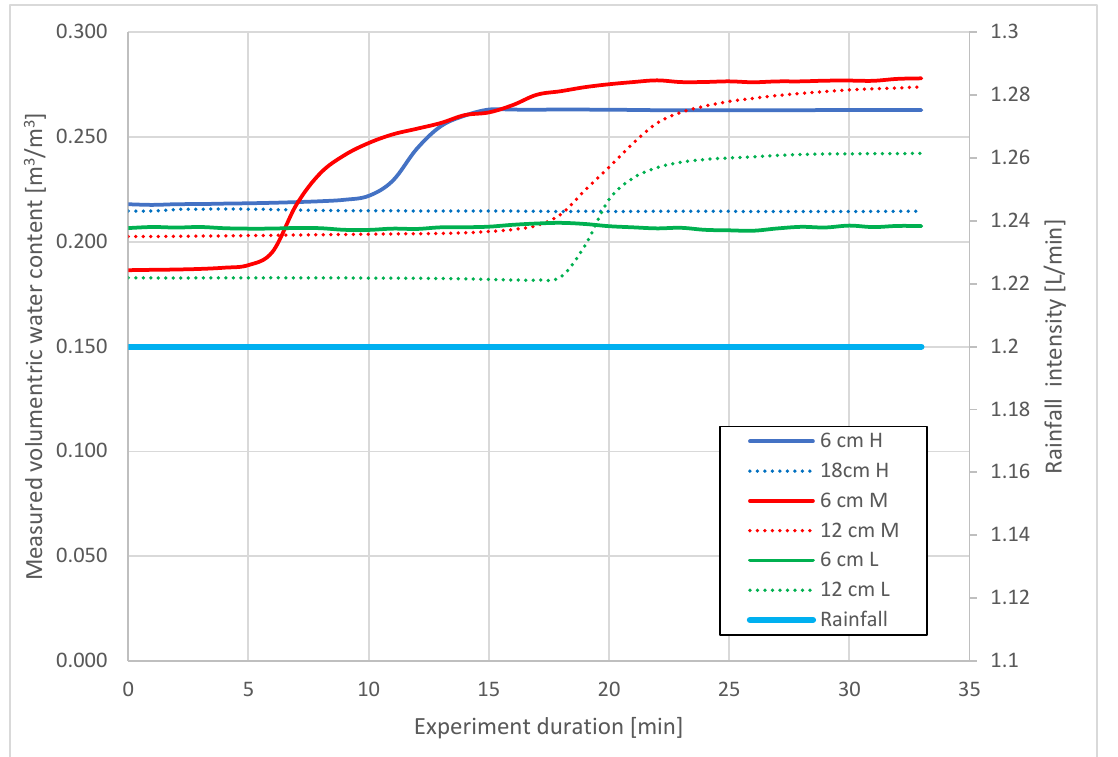
Figure 7. Measured volumetric water content during the SK10er experiment. Measured locations (H, M and L) are shown in Figure 2.